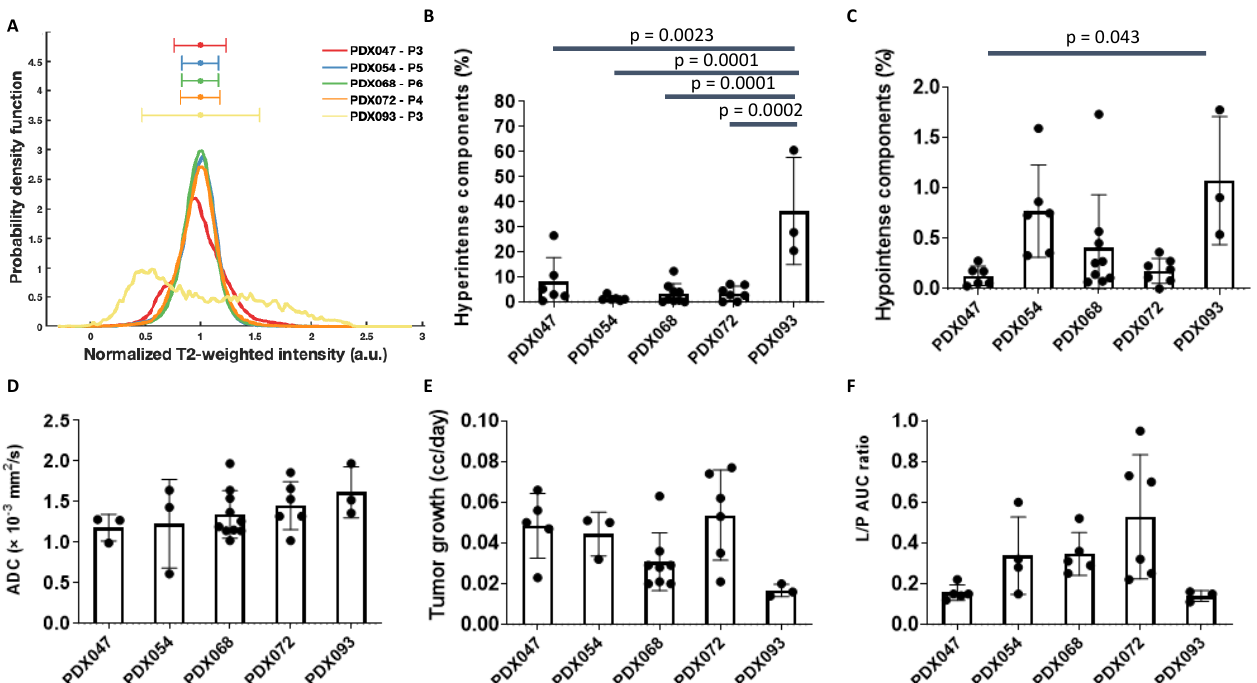
Figure 2. Multiparametric MRI of PDX tumors. ( A ) The normalized overlay (average representation of all tumors of each PDX) of T2-weighted intensities. Bar graphs show the % hyperintense ( B ) and % hypointense ( C ) components in all PDX tumors calculated from histograms of T2-weighted images. ( D ) ADC mean calculated for all PDX tumors showed similar water diffusion among PDX. ( E ) The tumor growth rate (cc/day) was calculated as the slope of the last 3 tumor volumes prior to HP MRI and the time (in days) between the first and final measurement. ( F ) The mean of the L/P AUC ratios for all PDX tumors. The significance of the one-way ANOVA with a Tukey’s multiple comparisons test is indicated above the plots. All p < 0.05 indicated statistical significance. a.u.= arbitrary units; AUC = area under the curve.